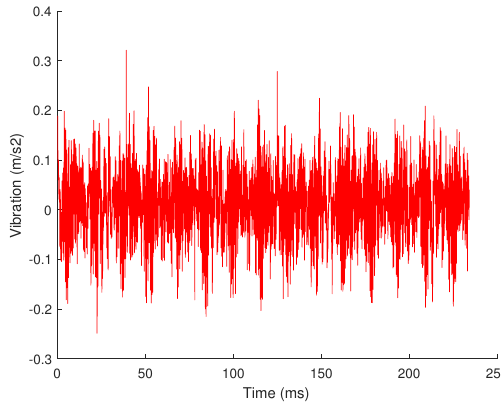
Figure 9. Vibration